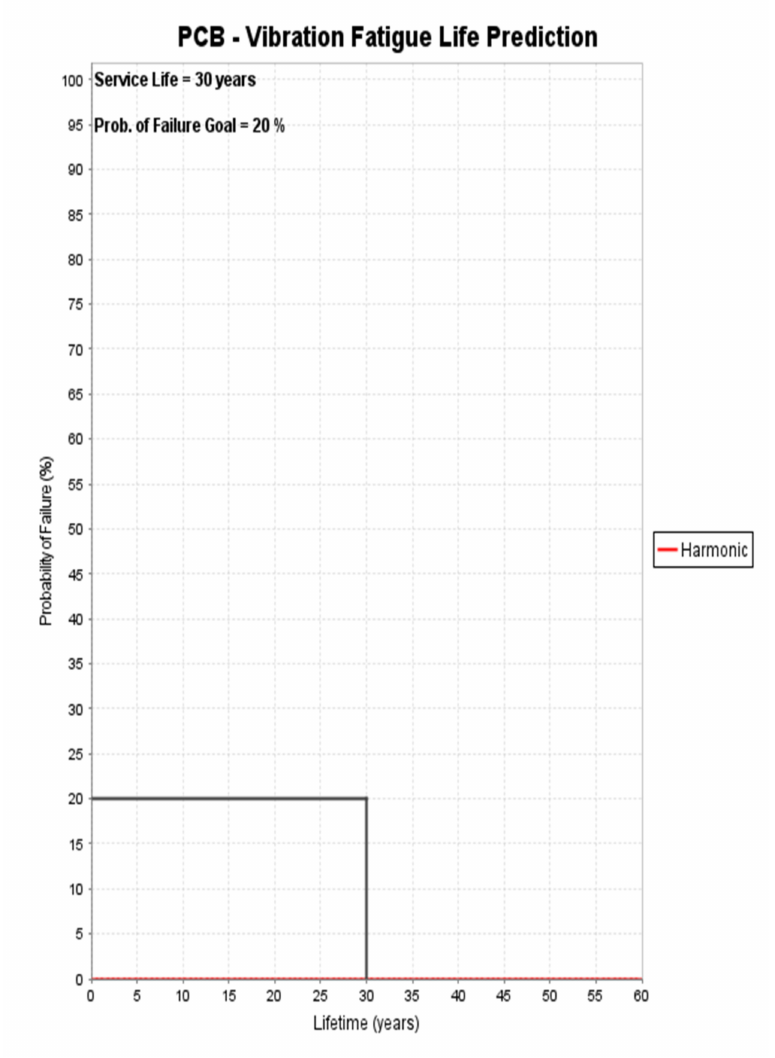
Figure 11. The lifetime (years) against probability of failure